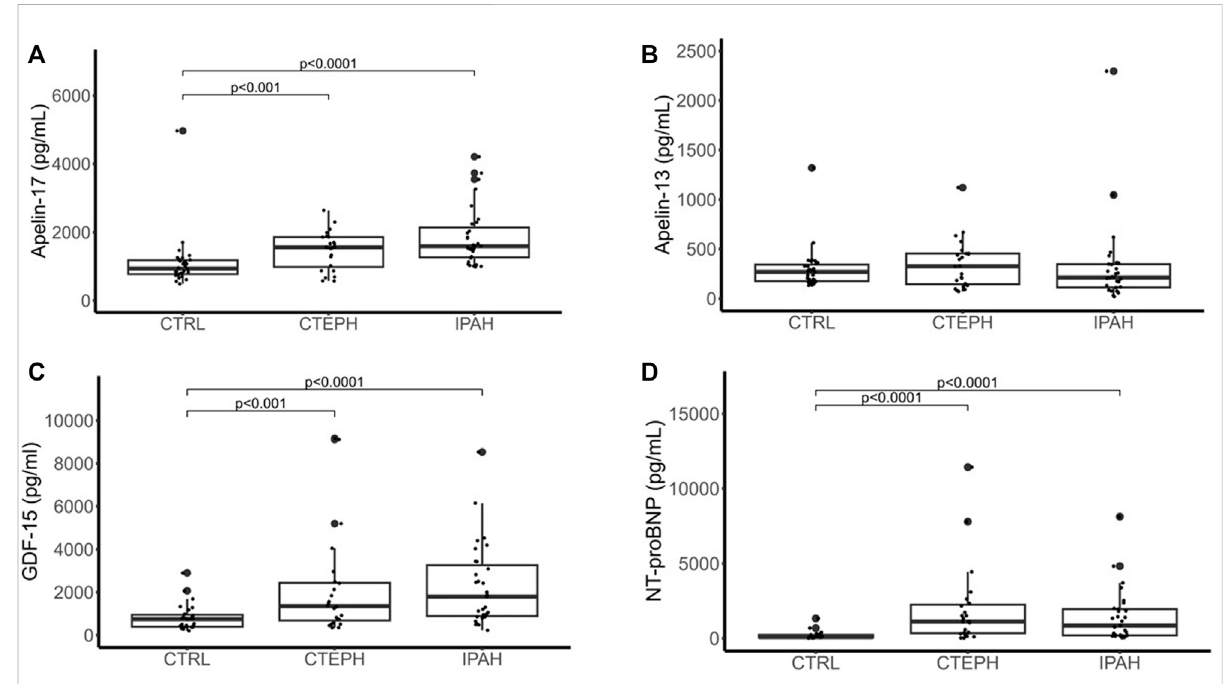
FIGURE 1 Serum levels of apelin-17 (A) , apelin-13 (B) , GDF-15 (C) and NT-proBNP (D) in n = 31 IPAH patients, n = 31 controls as well as n = 24 CTEPH patients represented as Whisker-Blot plots. Points above or below the plots represent outliers. p < 0.05 was considered statistically signi fi